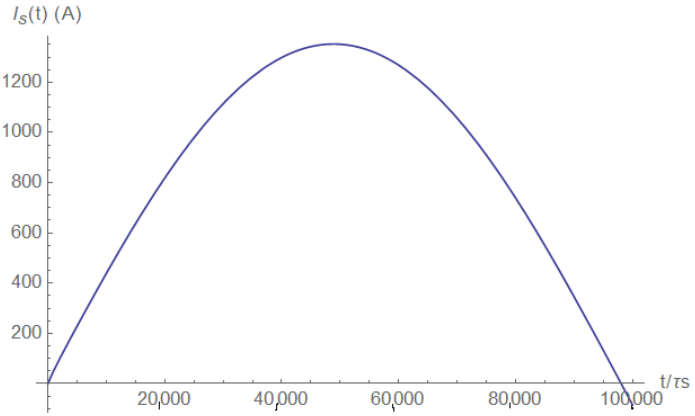
Figure A26. Steady-state short